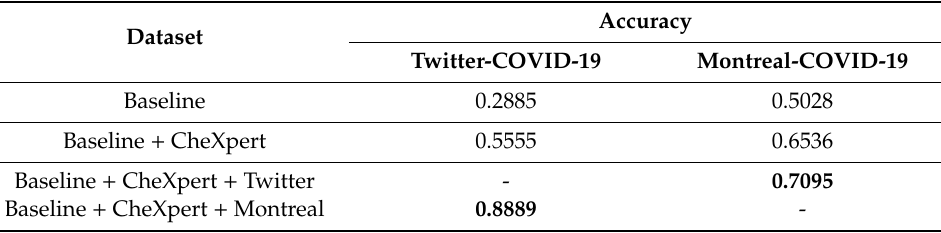
Table 10. Performance metrics achieved using augmenting the best-performing weakly labeled augmented training data with one of the COVID-19 CXR collections toward classifying another COVID-19 CXR collection as belonging to the viral pneumonia category.